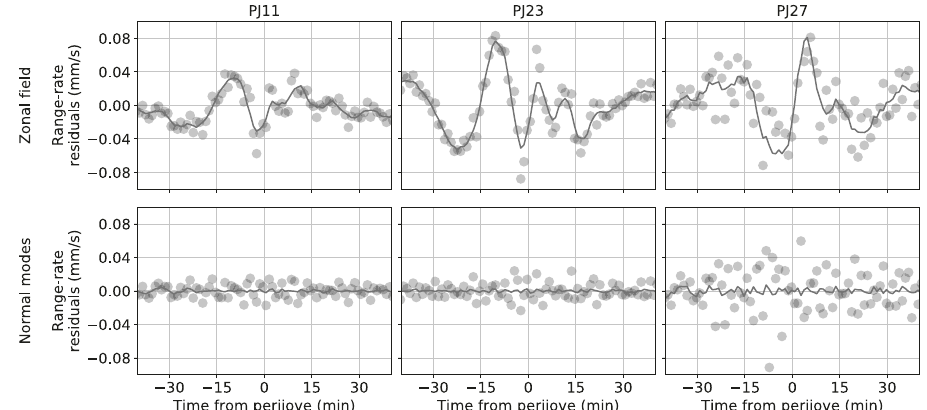
Fig. 1 | Juno two-way range-rate (Doppler) residuals in mm/s for selected pas- ses. Different dynamicalmodels are compared:static zonalgravity fi eld( fi rst row) or including normal modes (second row). The light black line is a moving average